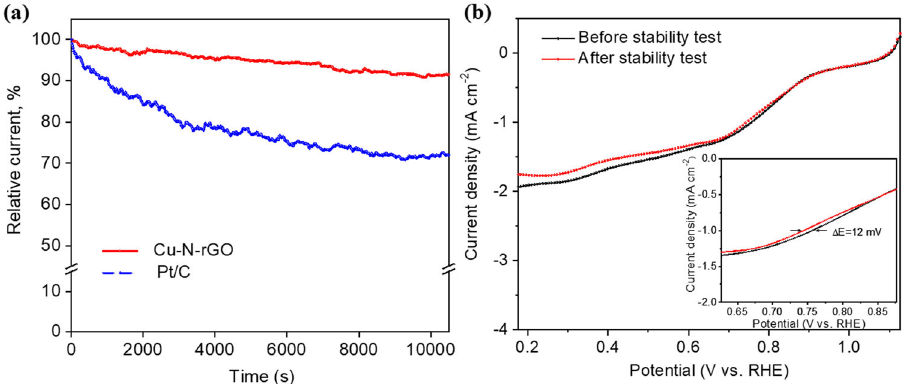
Fig. 10 Stability tests. a CA measurements on Cu-N-rGO and reference Pt/C catalysts in air-saturated 0.1 M KOH solution, b linear sweep voltammograms on Cu-N-rGO before and after the CA test (the inset shows the high magni fi cation in the 0.63 – 0.89 V